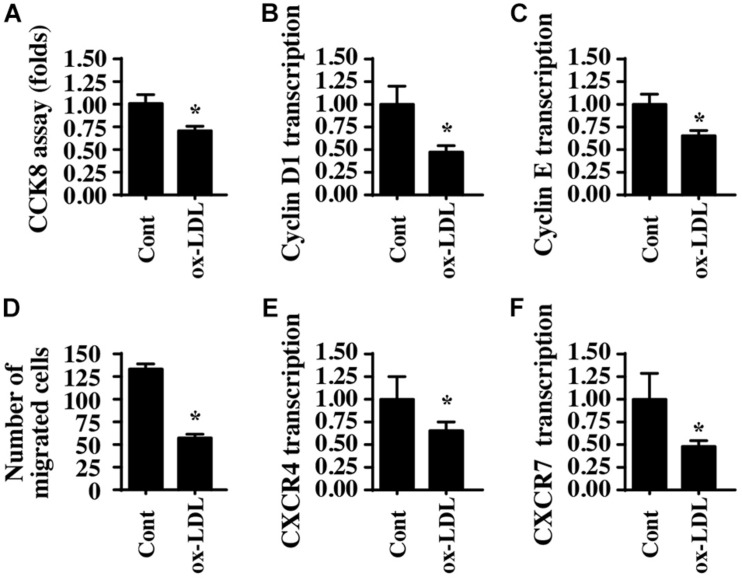
Endothelial cell proliferation and mobilization are impaired by ox-LDL. (A) Cell growth was measured through the CCK-8 assay. (B,C) The transcription of cyclin D1 and cyclin E was determined through qPCR. (D) A transwell assay was used to observe the cell migration response. (E,F) RNA was isolated from ox-LDL-treated endothelial cells and the levels of CXCR4 and CXCR7 were determined through qPCR. *p < 0.05.